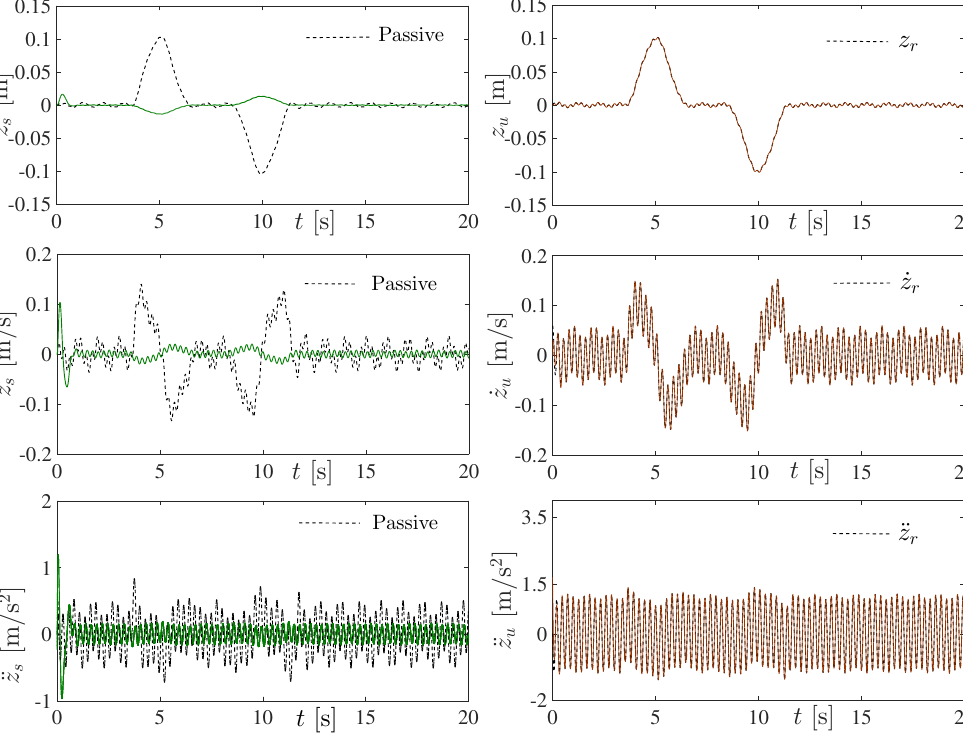
Figure 12. Responses of the active suspension system using measurements of velocity and disturbance